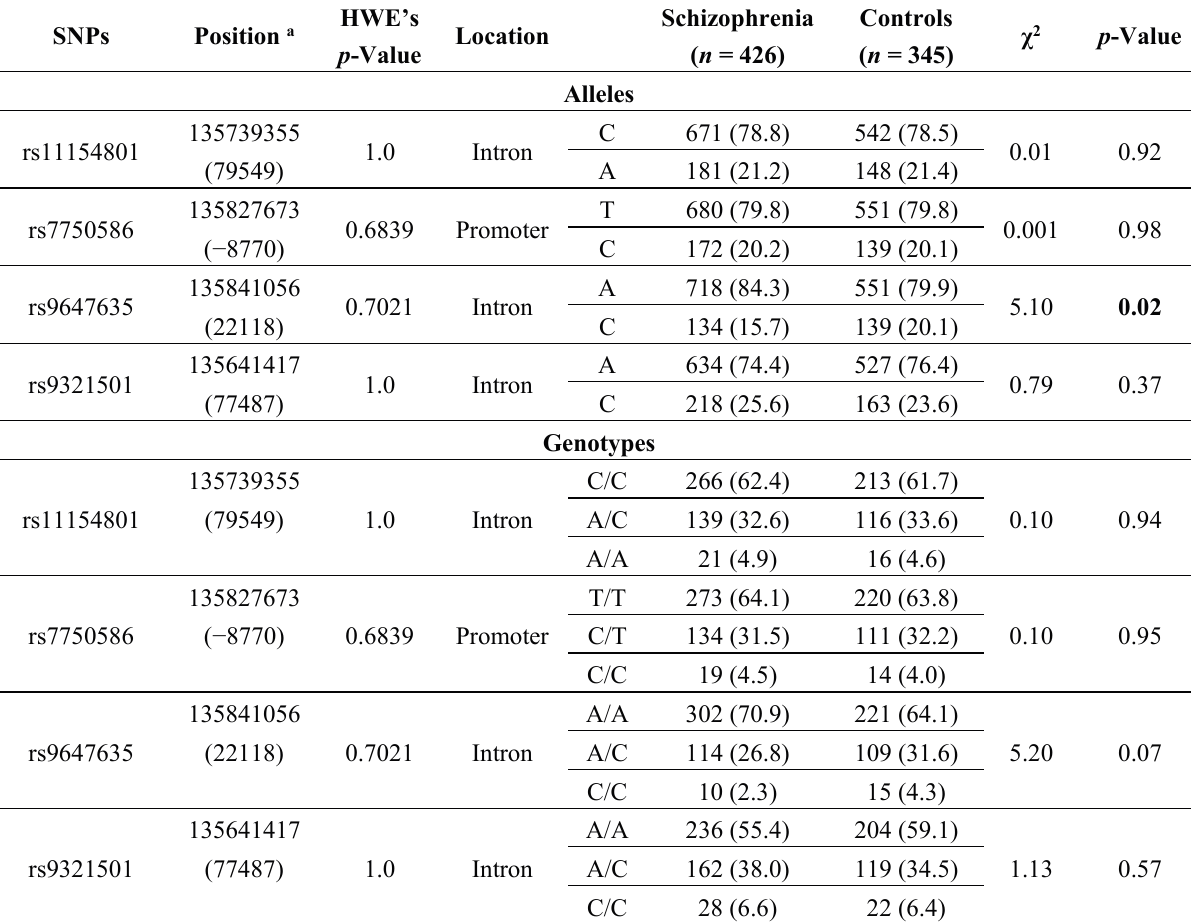
Table 2. Genotype and allele frequency of the SNPs under investigation in the present study. HWE, Hardy–Weinberg equilibrium.